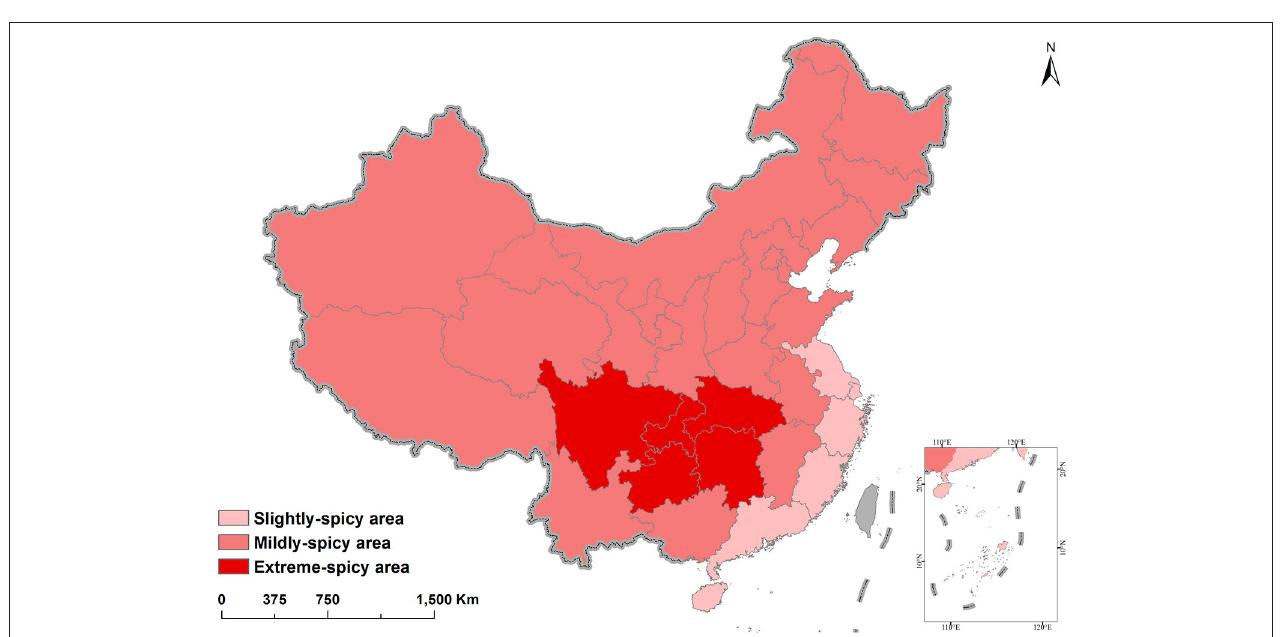
FIGURE 1 | Spatial distribution of pepper spiciness level in China. Data from China’s Taiwan, Hong Kong, and Macau are not available.